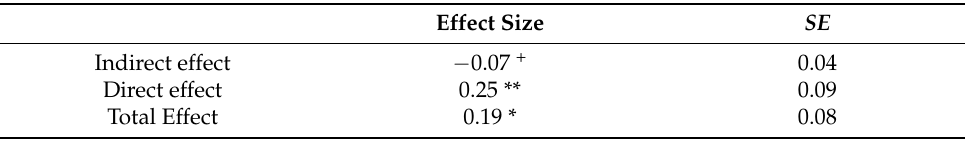
Table 5. Study 1 Indirect Effect, Direct Effect, and Total